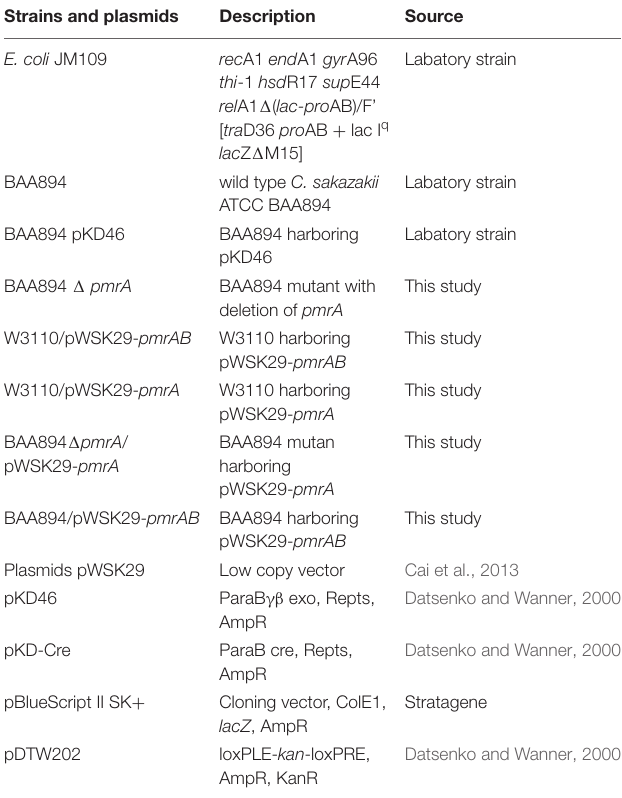
TABLE 1 | Bacterial strains and plasmids used in this